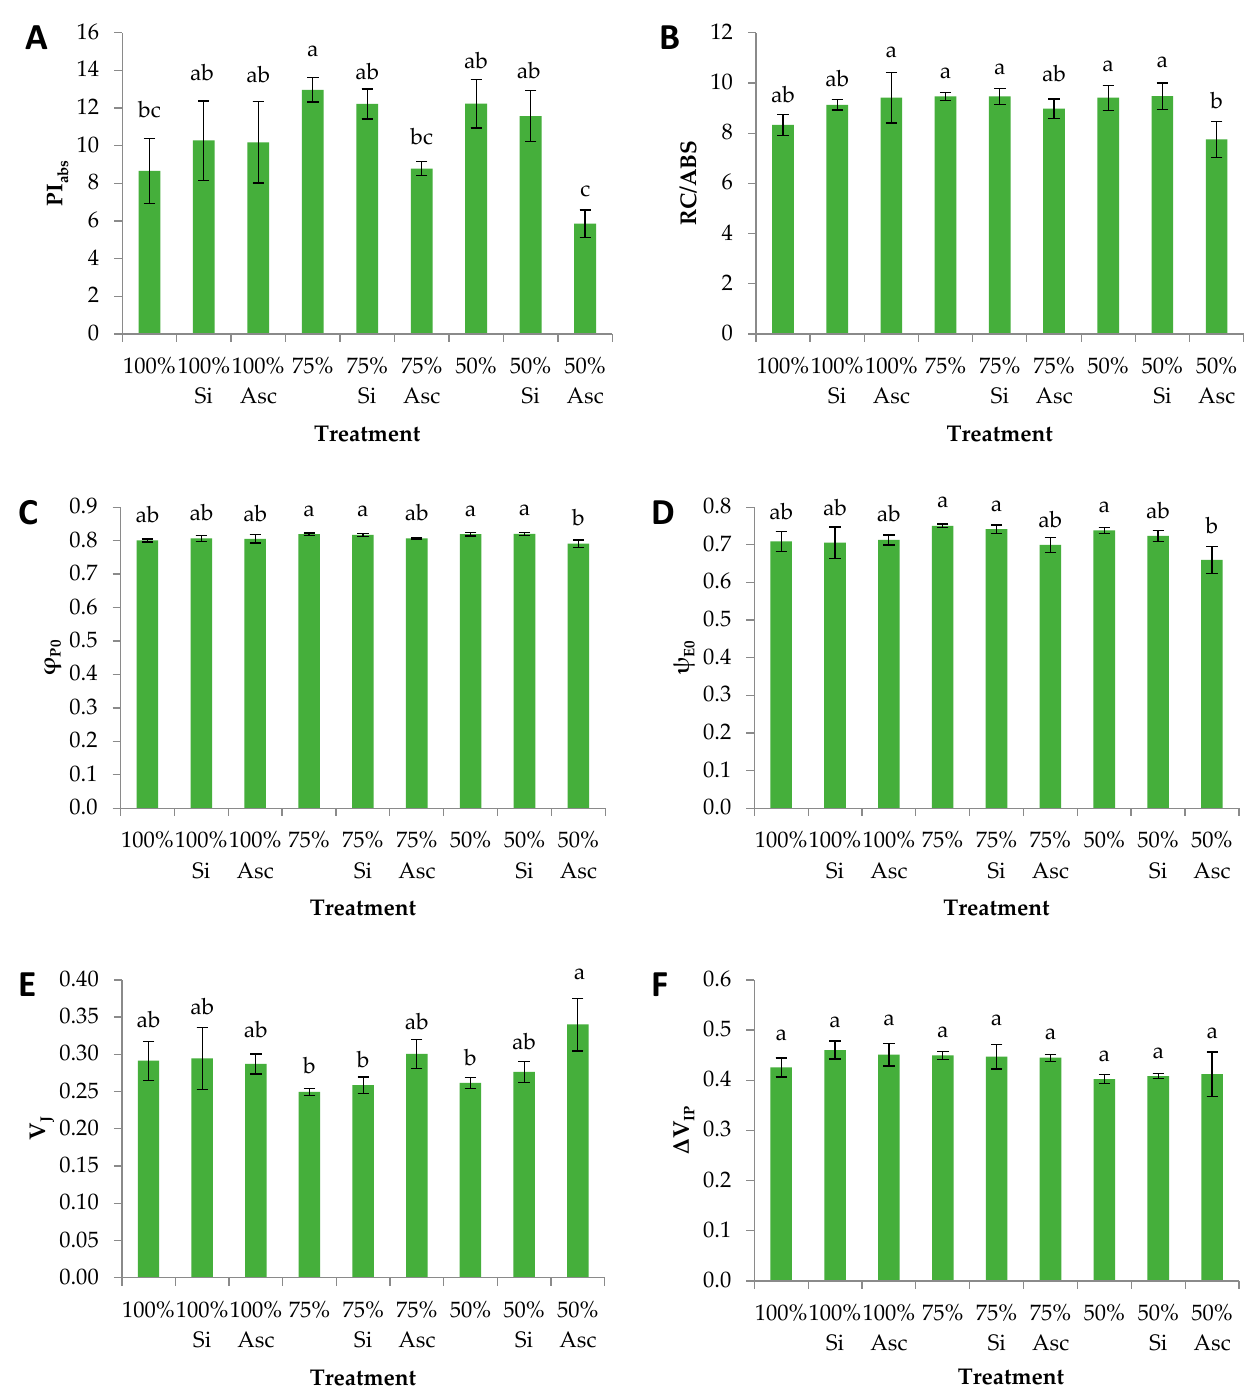
Figure 2. ( A ) PI abs , ( B ) RC/ABS, ( C ) ϕ P0 , ( D ) ψ E0 , ( E ) V J , and ( F ) ∆ V IP of watermelon plants 20 days after transplantation treated with two biostimulants (Si: silicon-based, and Asc: Ascophyllum nodosum seaweed) and additionally irrigated with different amounts of nutrient solution. Mean values (n = 6; ± SE) within a row followed by different letters are significantly different (a < 0.05).